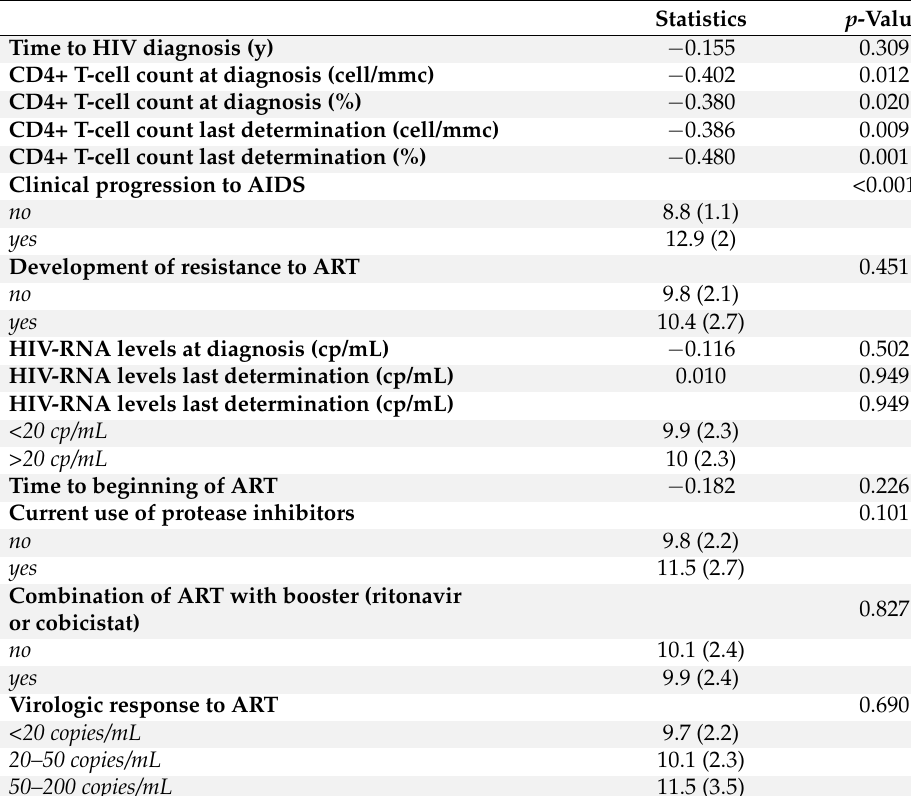
Table 2. Comparison between score and virological and immunological